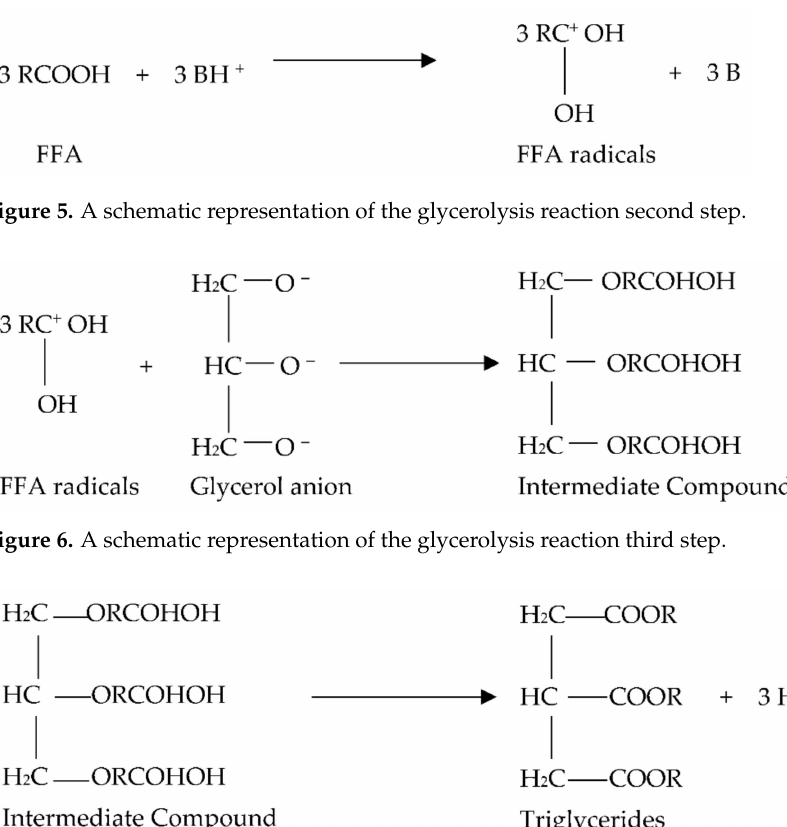
Figure 4. A schematic representation of the glycerolysis reaction first step.